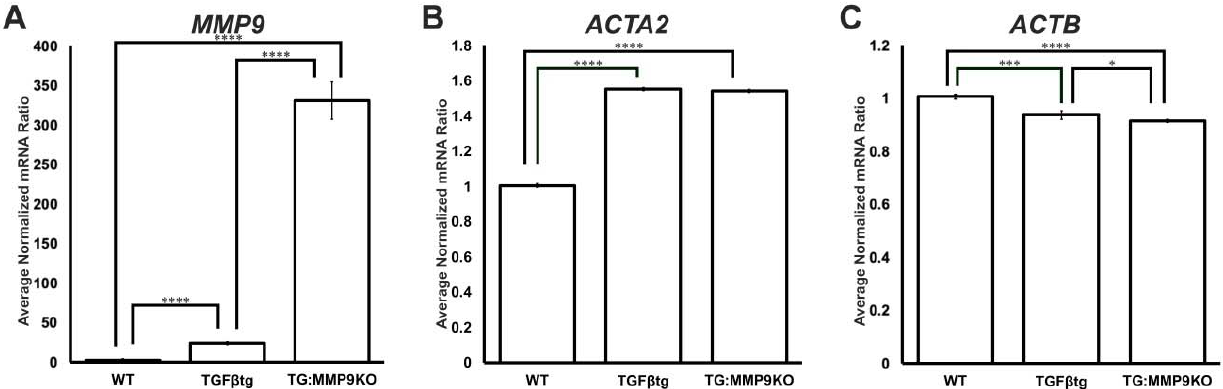
Figure 2. Graphs showing average expression of ACTA2, ACTB and MMP9 during NanoString analysis. Lenses were obtained from wildtype (WT) ( n = 4 experiments, where n = 3 lenses per experiment), TGF- β overexpressing (TGF β tg) ( n = 4 experiments, where n = 3 lenses per experiment) and TGF β tg on the MMP9KO background (TG: MMP9KO) ( n = 4 independent experiment, where n = 3 lenses per experiment) mice. The NanoString nCounter gene expression system was used to quantify the expression of MMP9 ( A ) , ACTA2 ( B ) and ACTB ( C ). The data was normalized to total RNA count, and the normalized mRNA ratios were calculated by referencing to one set of WT. Error bars indicate ± standard deviation of the average normalized mRNA ratios (* p < 0.05; *** p < 0.001; **** p < 0.0001).